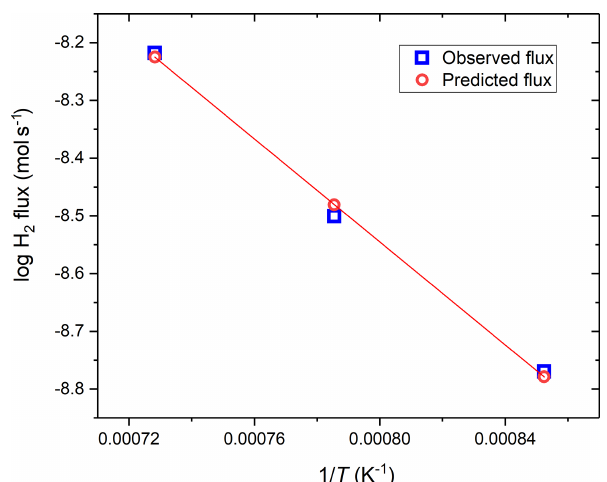
Figure 6. Back scattered electron image of the run product of a re- dox sensor experiment conducted at 1000 ◦ C for 24h at a predicted final log f O 2 of − 10 . 42bar (experiment no. 5). The darker grey parts are CoO crystals, whereas the bright patches are CoPd alloy. The CoPd alloy in this experiment contains 25 . 70 ± 0 . 47mole per- cent of Co, which indicates a log f O 2 of − 10 . 09bar.